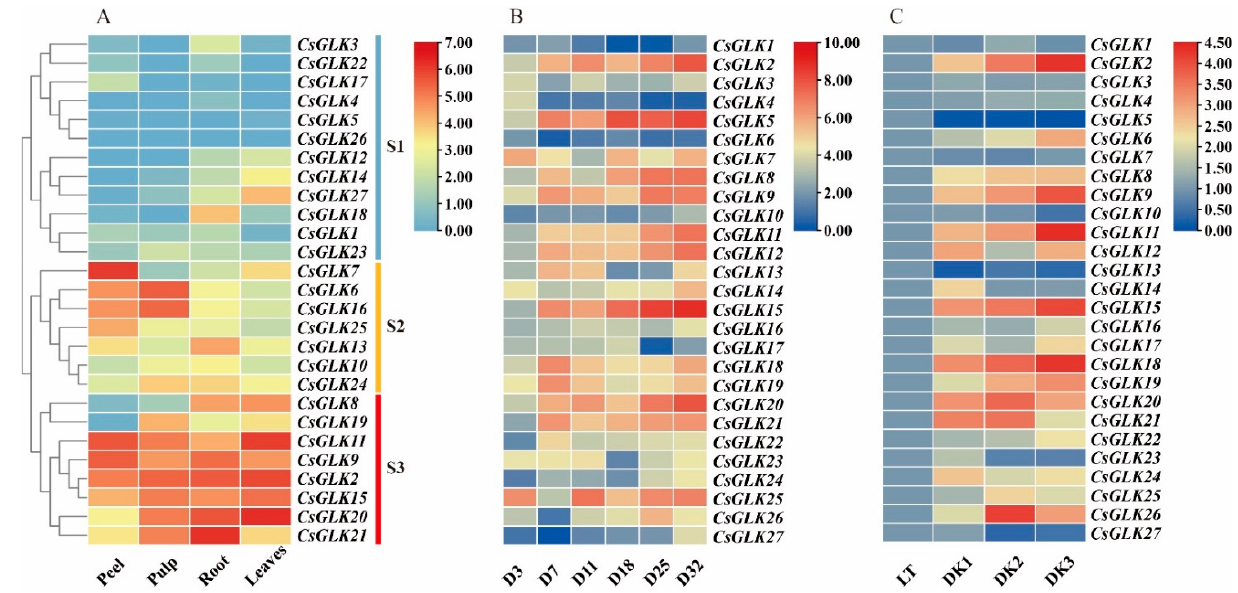
Figure 6. ( A ) Expression of CsGLKs in different tissues. ( B ) Expression of CsGLKs in different growth stages. ( C ) Expression of CsGLKs under dark stress. Color gradient from red to blue indicates that expression values change from high to low.